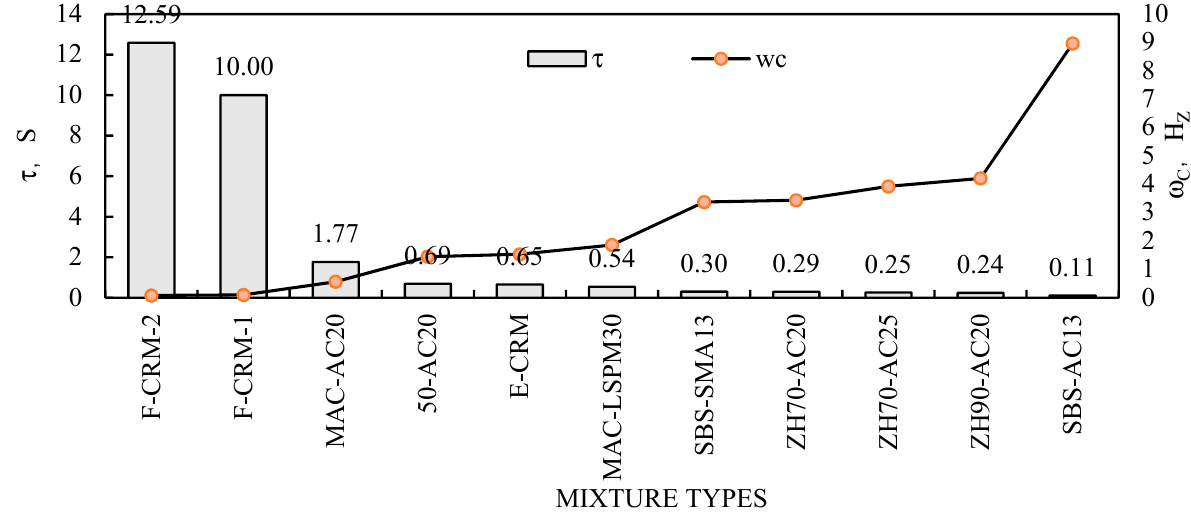
Figure 15. Comparison of relaxation time of different asphalt mixtures.